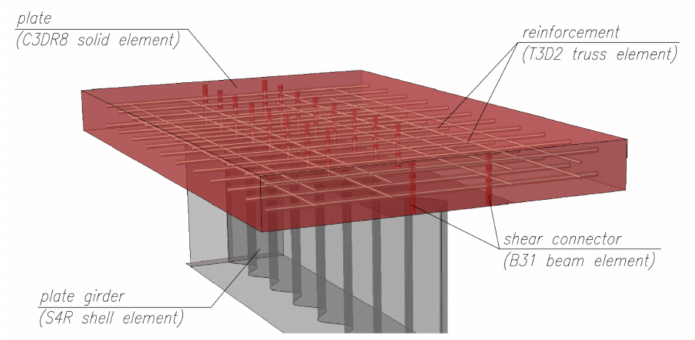
Figure 5. Visualization of the seating of the welding pins and reinforcement in the concrete slab of the beam.